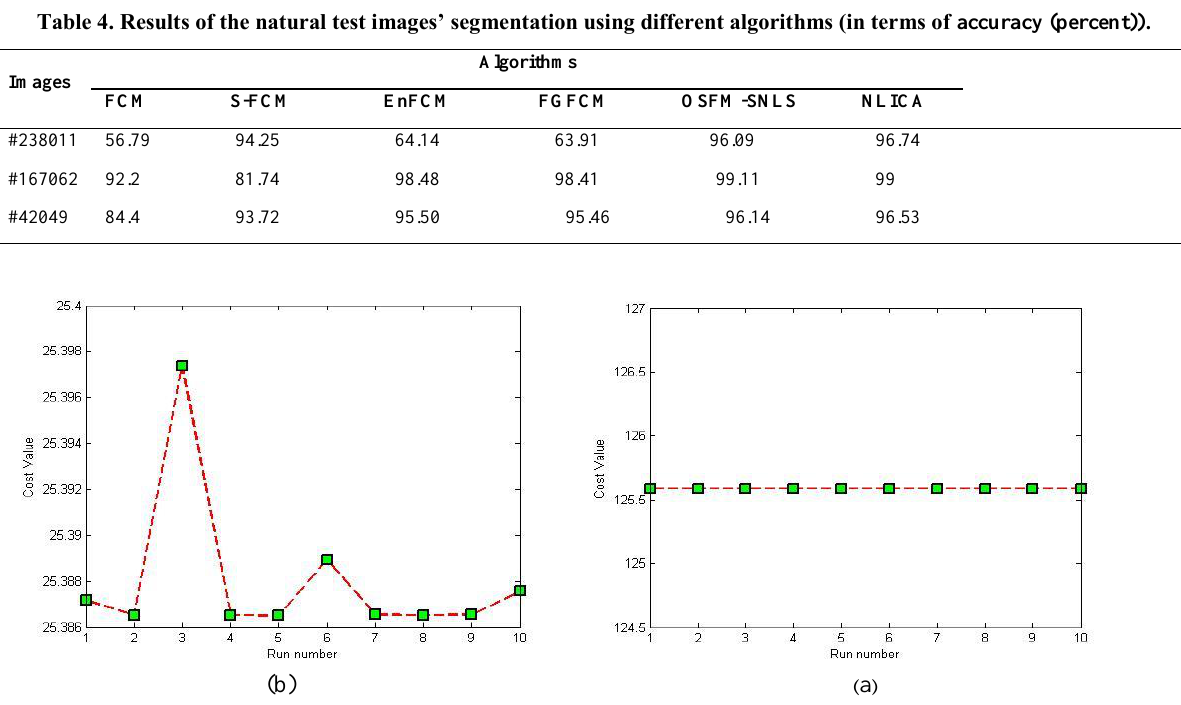
Figure 11. Stability diagram plotted using the results obtained in ten runs of the NLICA algorithm in segmentation process of the Berkley test images: (a) #238011 and (b) #42049.